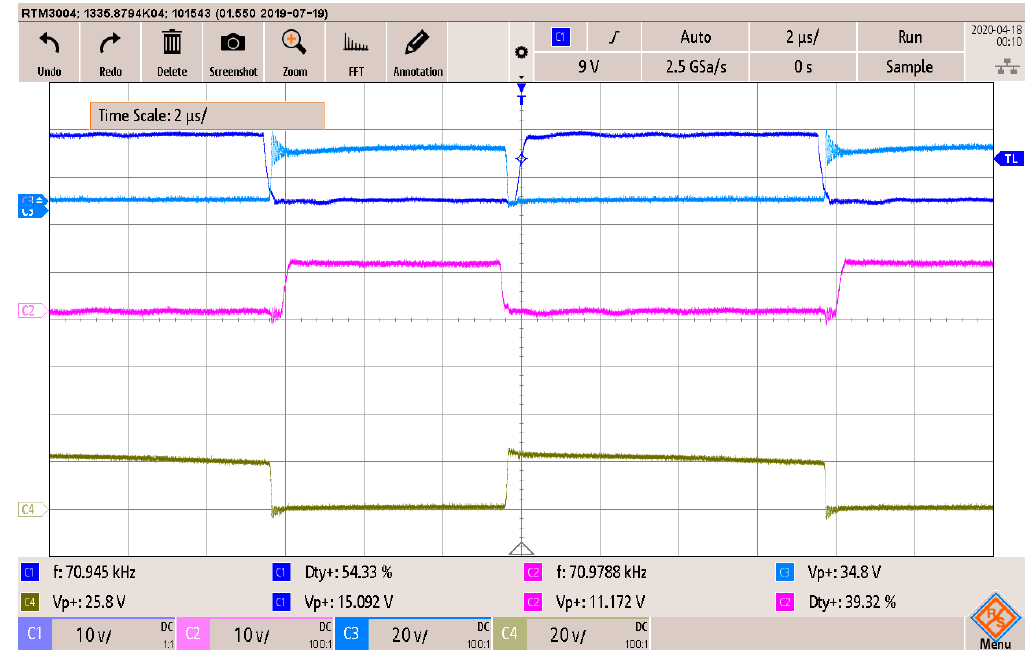
Figure 17. Waveforms of switch V GS and V DS with 10 V of input and 12 V / 1 A of output (CH1, V GS 1 ; CH2, V GS 2 ; CH3, V DS 1 ; CH4, V DS 2 ).